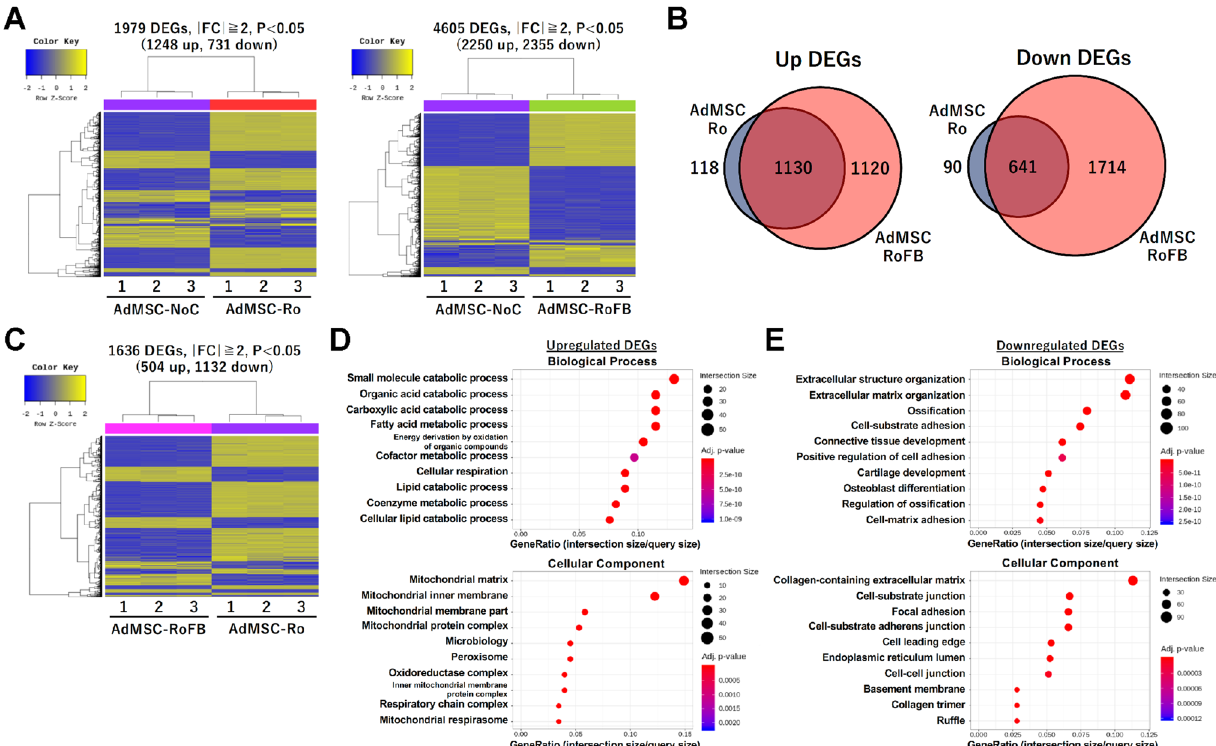
Figure 4. Genome-wide transcriptional analysis of AdMSC-derived adipocytes. ( A ) Heat map and hierarchical clustering analyses represent 1979 DEGs (|FC| ≧ 2, P < 0.05) and 4605 DEGs in AdMSC-Ro and AdMSC-RoFB, respectively, compared to AdMSC-NoC. The DEGs in AdMSC-Ro consist of 1248 up- and 731 down-regulated genes, while the DEGs in AdMSC-RoFB consist of 2250 up- and 2355 down-regulated genes. ( B ) Venn diagrams represent the overlap of the up- and down-regulated DEGs in AdMSC-Ro and AdMSC-RoFB. ( C ) Heat map and hierarchical clustering analysis represent 1636 DEGs (|FC| ≧ 2, P < 0.05) between AdMSC-RoFB and AdMSC-Ro. The DEGs consist of 504 up- and 1132 down-regulated genes. ( D , E ) GO analysis was performed by means of DAVID in the up-regulated DEGs ( D ) and the down-regulated DEGs ( E ). Top 10 GO terms were shown in the categories of Biological Process and Cellular